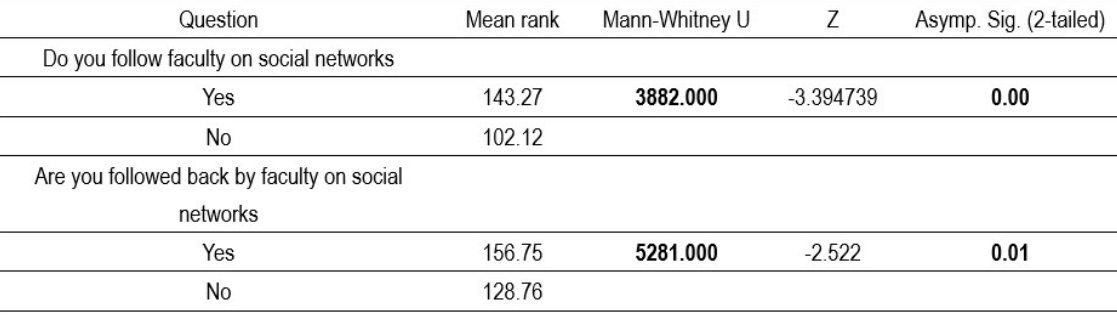
Students’ faculty image perception depending on whether they are following faculty account, and whether they are followed back on social